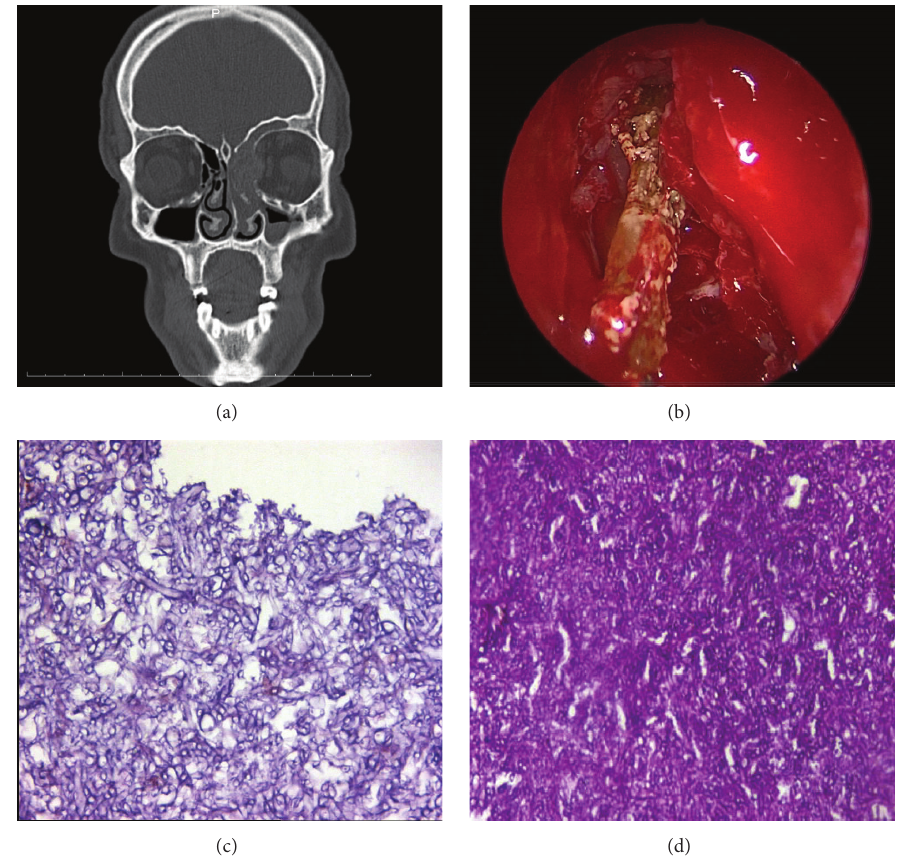
Figure 2: (a) Paranasal sinus computed tomography showing a soft tissue mass filling the left nasal cavity and ethmoid, frontal, and sphenoid sinuses and indenting the medial rectus muscle by destructing the lamina papyracea. (b) Endoscopic view of the yellow-green colored fungal debris. (c) Hematoxylin and eosin stain of the tissue revealing a group of narrow branching septate hyphae ( × 400). (d) Periodic acid-Schiff stain of the tissue showing branching septate